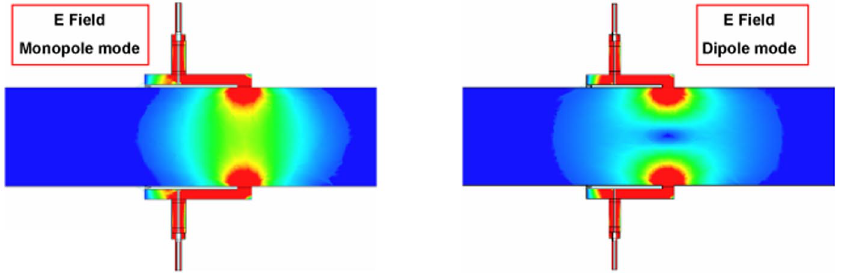
FIG. 6. (Color) Electrical fields for the monopole and dipole modes.